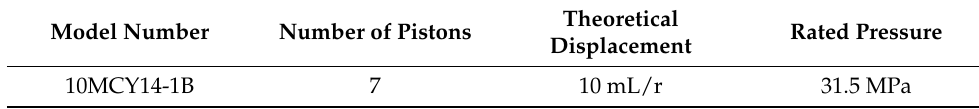
Table 2. Basic parameters of piston pump.